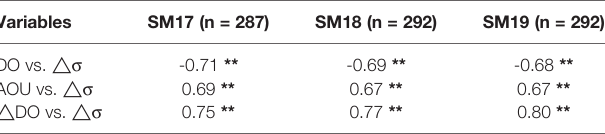
TABLE 1 | The Correlation Coef fi cient, r, between bottom DO, AOU, △ DO and △ s .